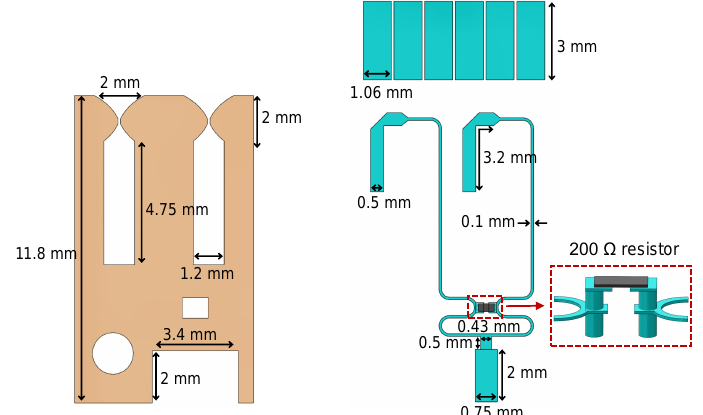
Figure 2. Detailed geometry of the proposed TCDA periodic unit cell (including the front dipole layer, FSS, Marchand balun and Wilkinson